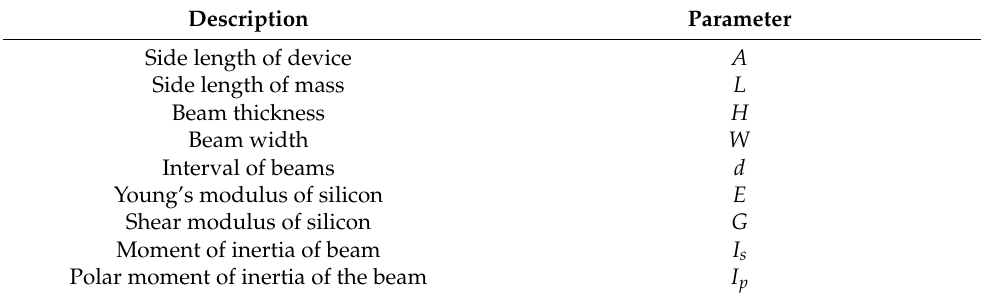
Table 1. Structure Table 1. Structure parameters.